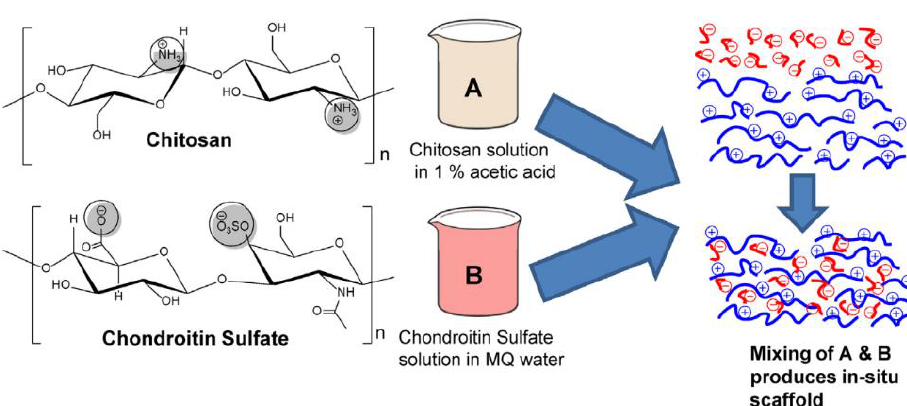
Figure 3. Formation of chitosan–chondroitin sulfate polyelectrolyte complex scaffold for chronic wound management. Reprinted from [59], copyright 2021, with permission from Elsevier.